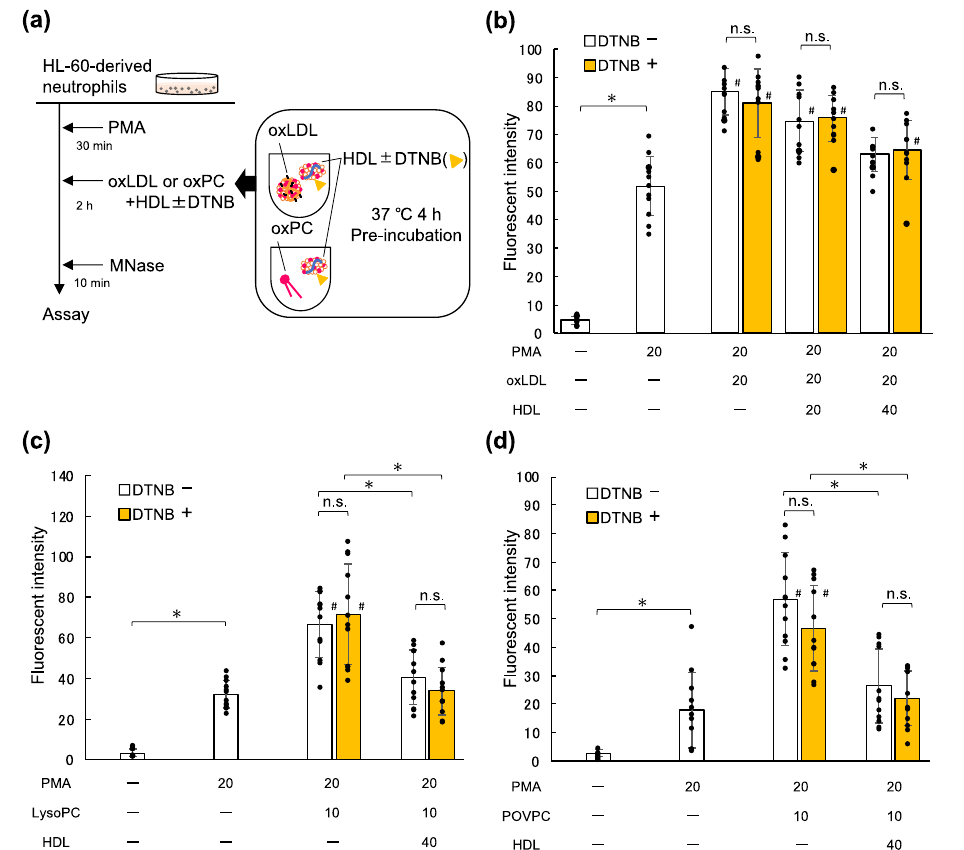
Figure 4. HDL suppresses NET formation even when LCAT is inhibited with DTNB. ( a ) Experimental scheme. HDL was pre-treated with or without 1 mM DTNB, an inhibitor of LCAT activity, at 37 ◦ C for 30 min, and then further incubated with oxLDL at 37 ◦ C for 4 h. HL-60 cells were differentiated into neutrophil-like cells using 2 µ M AtRA and then treated with or without PMA for 30 min, following which the cells were incubated with 20 µ g/mL oxLDL alone or with either 20 or 40 µ g/mL DTNB-treated HDL for 2 h. After incubation, the DNA released upon MNase digestion was stained with SYTOX ® Green. ( b ) HL-60-derived neutrophils primed with PMA were incubated for 2 h with 20 µ g/mL oxLDL or oxLDL plus HDL pre-treated with 1 mM DTNB. The data represent the mean ± SD from four experiments, each carried out in triplicate; each dot represents one datapoint. Asterisks indicate statistical significance (* p < 0.05), while sharps indicate statistical significance against the cells treated with 20 nM PMA alone (# p < 0.05). ( c , d ) HL-60-derived neutrophil-like cells were treated with or without PMA, then incubated for 2 h with 10 µ M lysoPC alone or that plus 40 µ g/mL HDL pre-treated with or without DTNB ( c ). Similarly, cells treated with PMA were incubated for 2 h with 10 µ M POVPC alone or that plus 40 µ g/mL native HDL, in the presence or absence of DTNB ( d ). The data represent the mean ± SD from four experiments, each carried out in triplicate; each dot represents one datapoint. Asterisks indicate statistical significance (* p < 0.05), while sharps indicate statistical significance against the cells treated with 20 nM PMA alone (# p < 0.05). HDL, high- density lipoprotein; NET, neutrophil extracellular trap; LCAT, lecithin cholesterol acyltransferase; DTNB, 5,5 (cid:48) -dithio-bis-(2-nitrobenzoic acid); oxLDL, oxidized low-density lipoprotein; AtRA, all- trans retinoic acid; PMA, phorbol 12-myristate 13-acetate; lysoPC, lysophosphatidylcholine;